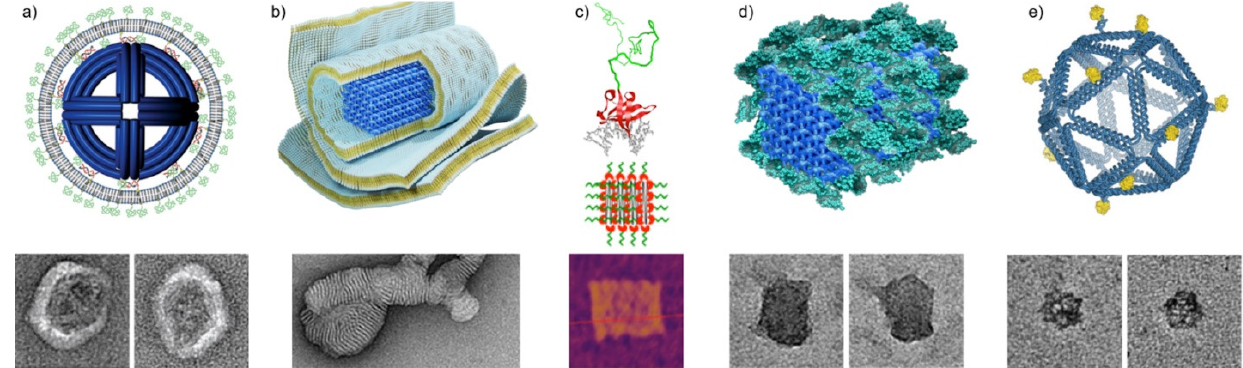
Figure 4. DNA origami directed assemblies mimicking virus structures. ( a ) Virus-inspired lipid membrane coating of DNA origami octahedron [46]. TEM insets are 100 nm × 100 nm. ( b ) Multilamellar lipid assemblies on 60HB DNA origami [47]. The TEM inset is 125 nm × 250 nm. ( c ) Modular protein polymer with a nonspecific DNA binding domain coating a DNA origami tile [51]. Green: C 8 polypeptide bristle. Red: B Sso7d binding domain. Gray: dsDNA. The AFM inset is 200 nm × 200 nm. ( d ) Inert bovine serum albumin coating of 60HB DNA origami [52]. The TEM insets are 80 nm × 80 nm. ( e )